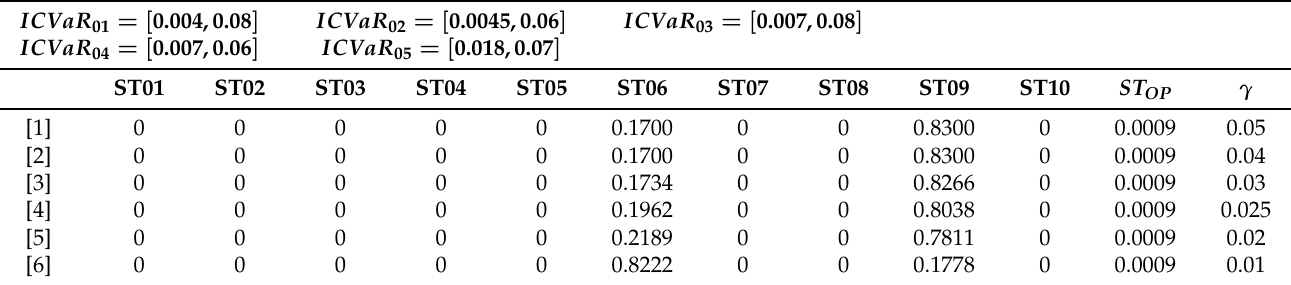
Table 5. Portfolio, Model 1 with different ICVaR 0 j for different j = 1, · · ·